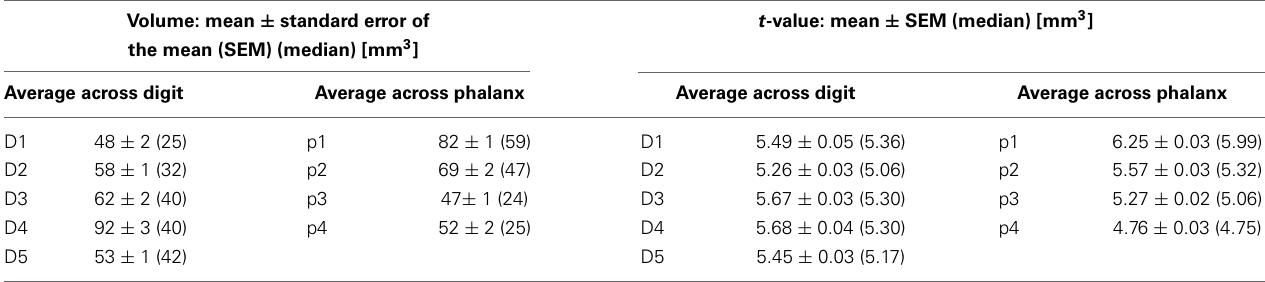
Table 2 | Volume and t -values of BOLD activations across and within digits.